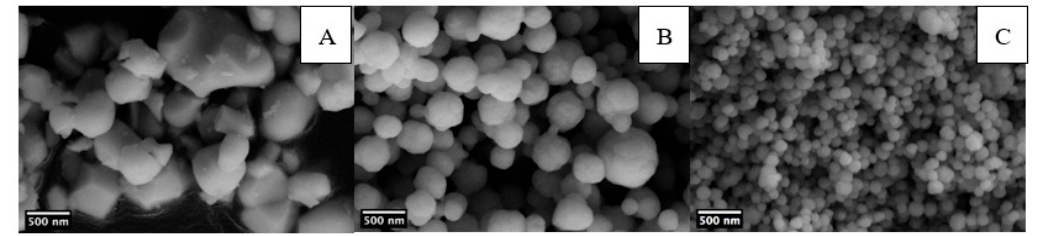
Figure 4. SEM micrographs of BT_comm ( A ), BT_900 ( B ), and BT_H_900 ( C ).